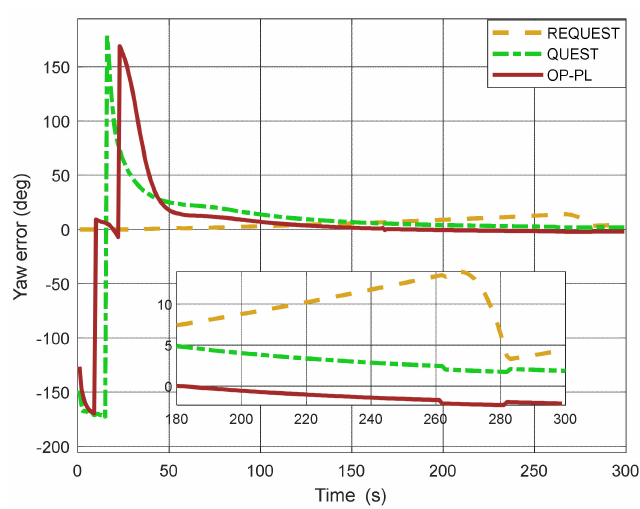
Figure 10. Curves of yaw angle